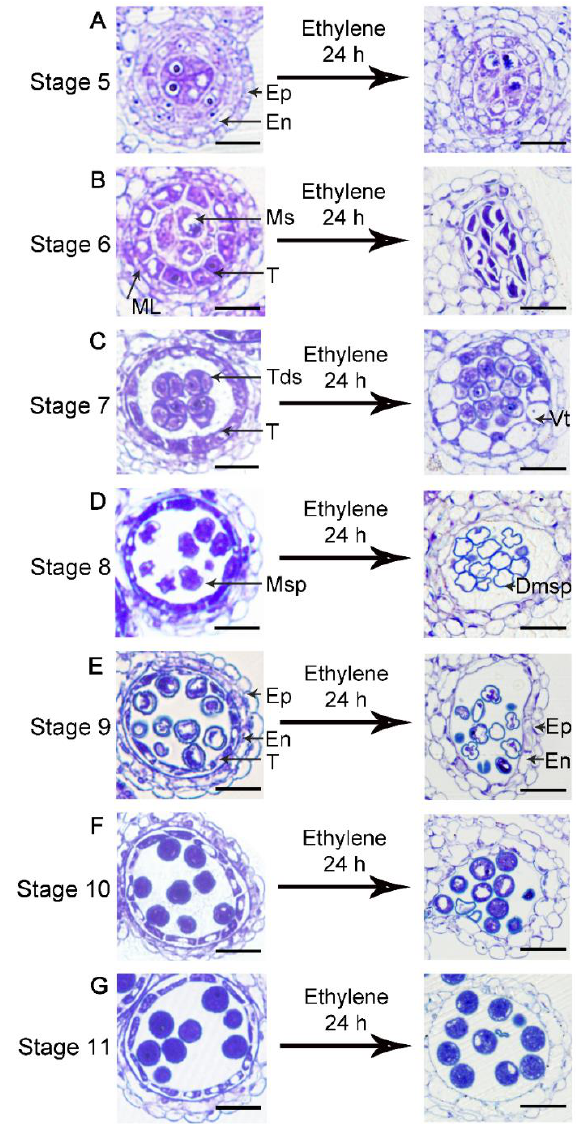
Figure 3. Ethylene treatment resulted in the degeneration of tapetum and microspores. ( A – G ) Semi- thin sections of Col anther before and after ethylene treatment (100 µL L −1 for 24 h). Note for the degeneration of tapetal layer and microspores. Bars = 20 µm. Ms: microsporocyte; Tds: tetrad; Msp: microspores; Ep: epidermis; En: endothecium; ML: middle layer; T: tapetum; Vt: Vacuolated tapetum; Dmsp: degenerated microspores.